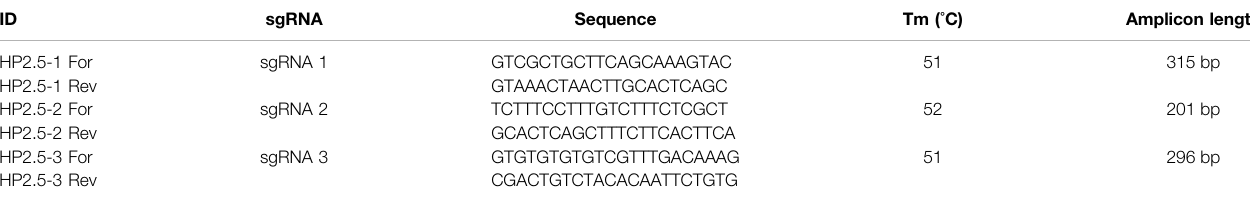
TABLE 2 | Primers designed to verify sgRNA cleavage ef fi